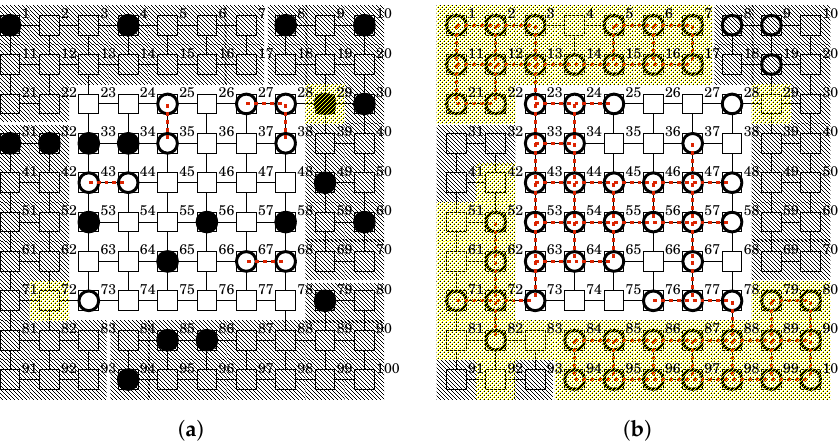
Figure 9. A state transition of the BDS for the IoT network with hierarchical observability and controllability. ( a ) State at t = 0 + . The BDS sent white-hat worms to 10 observable nodes in order to disinfect 20 malicious bots; ( b ) State at t = 10,000 − . The BDS will command self-destruction to the white-hat botnet according to the Withdrawal strategy. Table 2. Simulation results in the hierarchical case. (a) Lifespan (cid:96) = 3